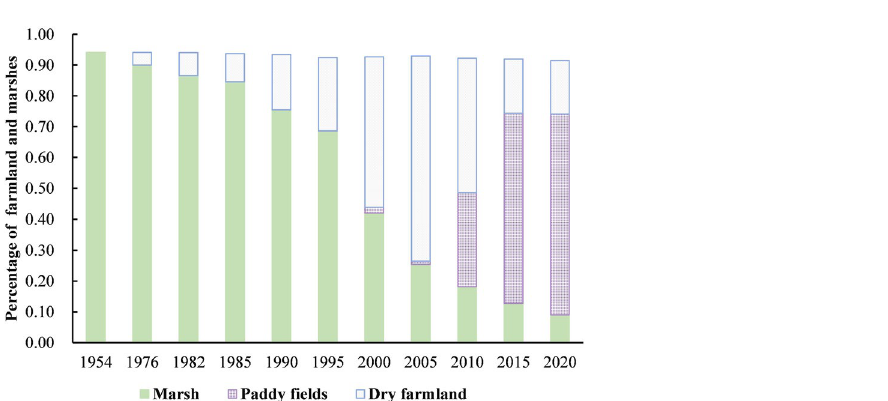
Figure 3. Spatial pattern of land cover types of the typical transect in 1954–2015. Figure shows the changes of landscape patterns in the Sub-Sangjiang Plain from 1954 to 2020. The landscape matrix from marshes changed into farmland.